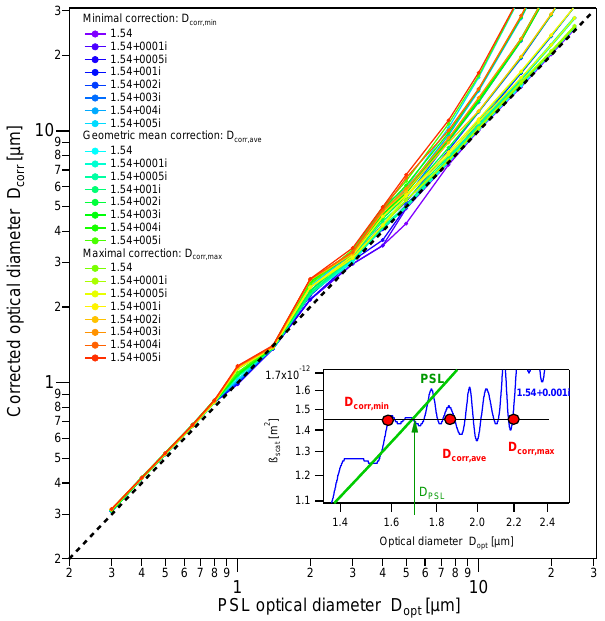
Fig. A2. OPC diameter correction curves for a complex refractive index with a fixed real part of 1.54 and an imaginary part ranging from 0i to 0.005i. Due to the wiggled and non-monotonic shape of the curves shown in Fig. A1, the diameter correction is not bijec- tive. Therefore, minimal ( D corr , min ), geometric mean ( D corr , ave ) as well as maximal ( D corr , max ) correction functions are shown (see illustration in the Figure